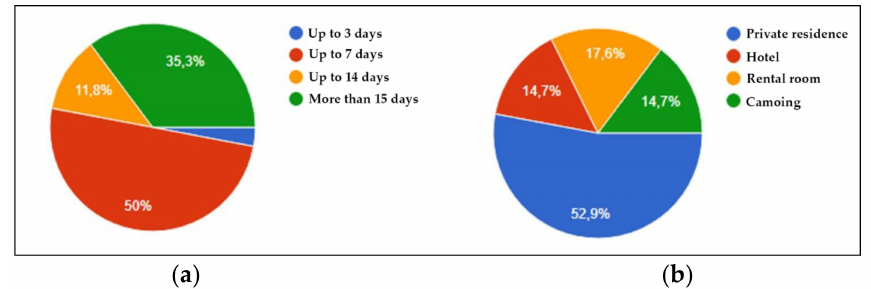
Figure 11. Pie diagrams of ( a ) the duration of the participant’s stay in Kythera and ( b ) the accommo- dation they used during their stay.